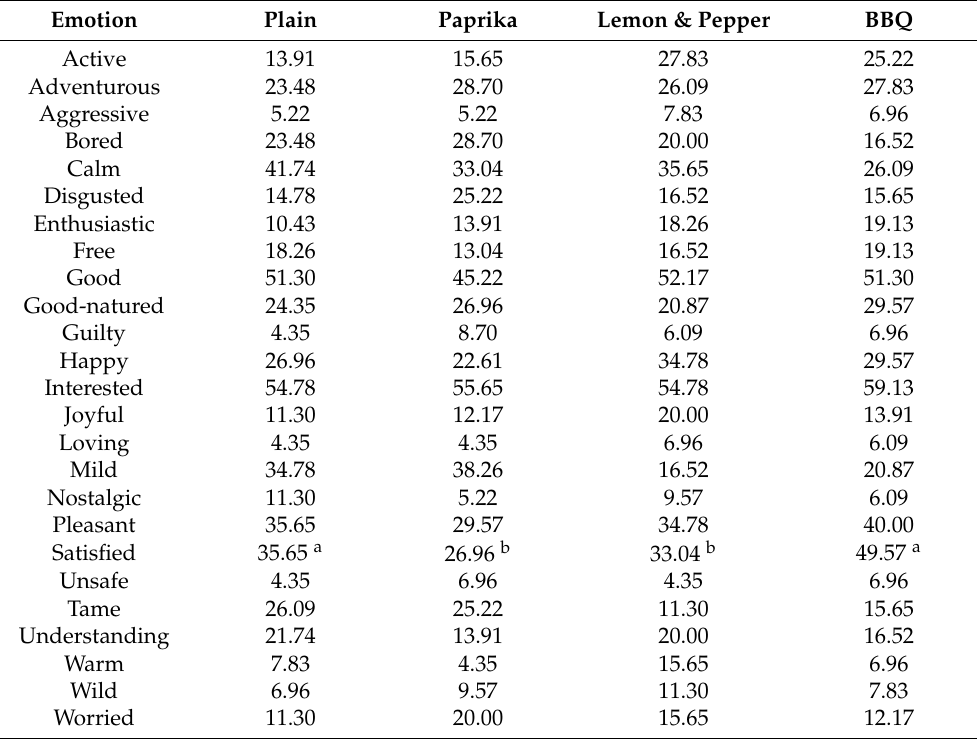
Table 5. Consumer emotions elicited by catfish skin chip, presented as percentage (%) of N = 115 consumers using a check-all-that-apply